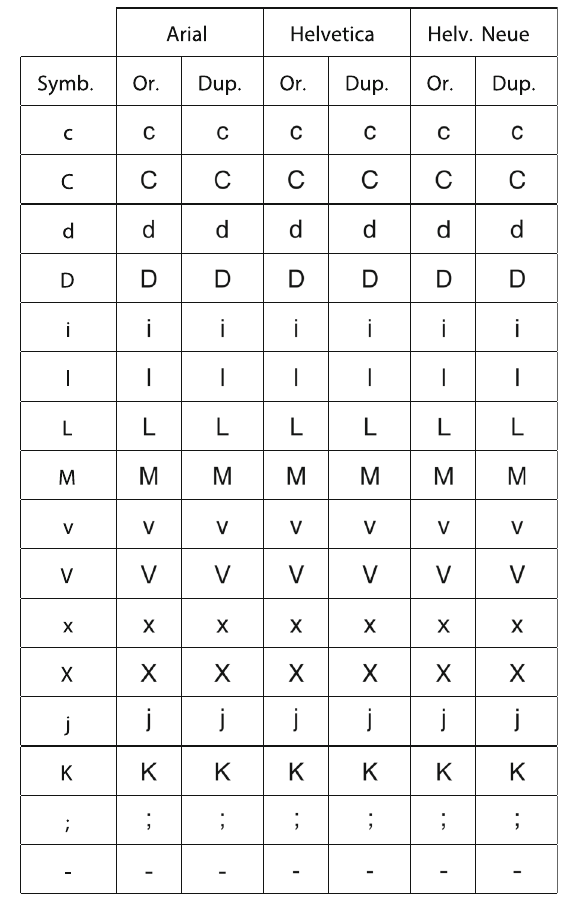
Fig. 9 Confusable symbols rendering in web fonts. Original (Or.) and